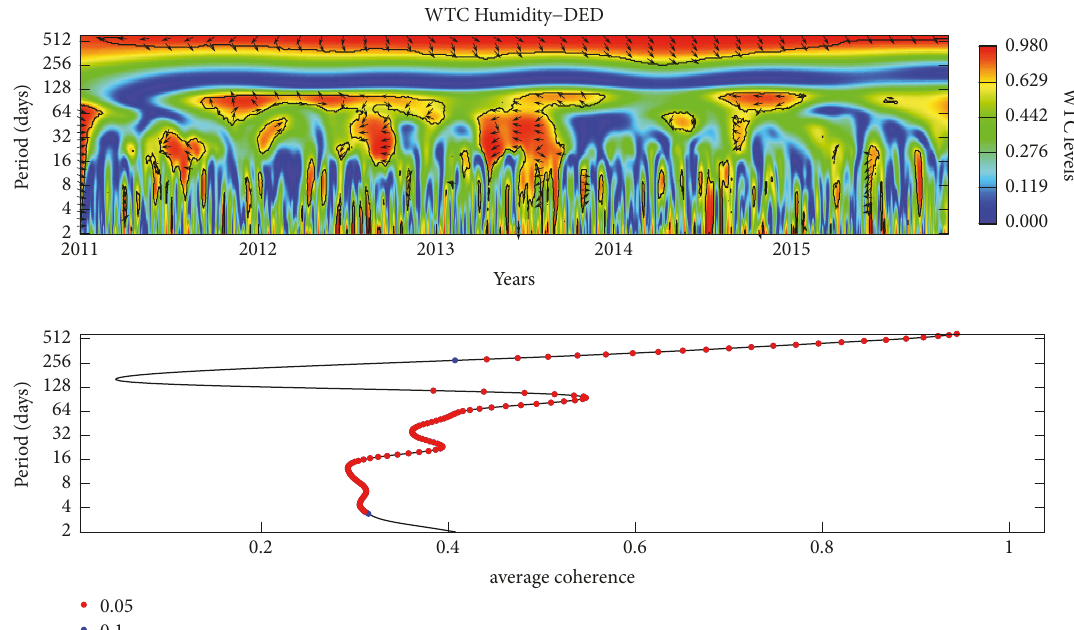
Figure 3: WTC, phase analysis, and average coherence between the relative humidity and the daily electricity demand. The black lines show area with 95% of confidence while red and blue points depict the points of 5% and 10% significance level.